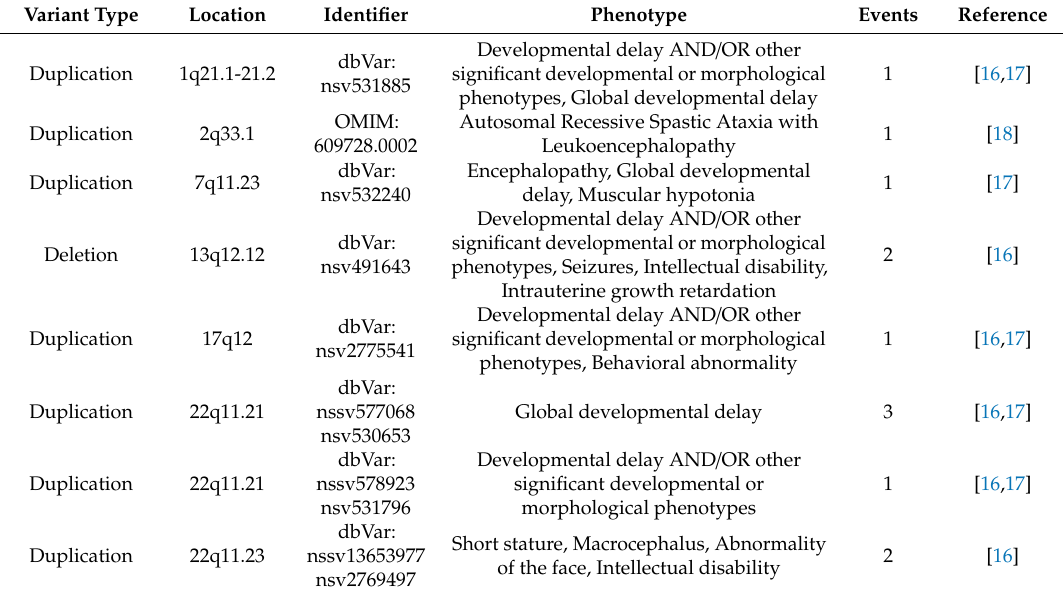
Table 1. Variants overlapping with CNVs that were previously observed among patients with pathogenic phenotypes. Data acquired from the ClinVar database.